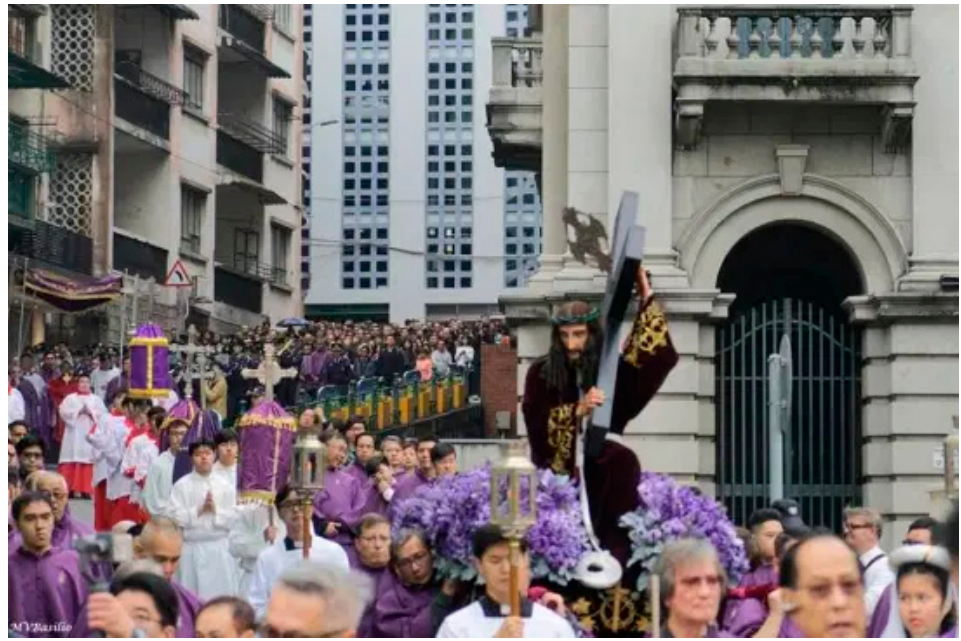
Figure 2. Procession of Bom Jesus , 10 March 2019 (image courtesy of Manuel V. Basílio).